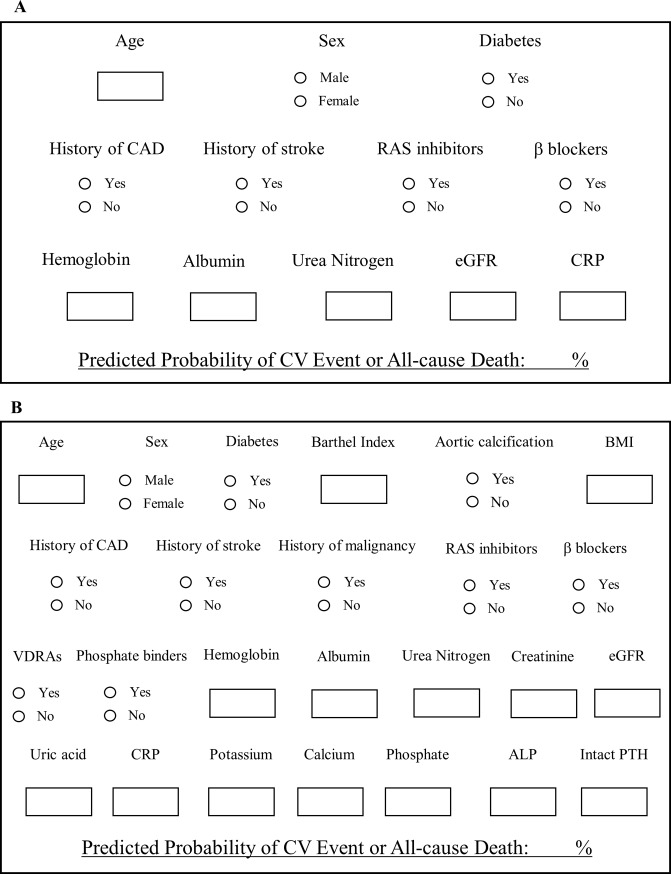
Automatic calculation sheets of predicted incidence of cardiovascular events or all-cause mortality within 1 year after dialysis initiation.A: simple model B: complex model.